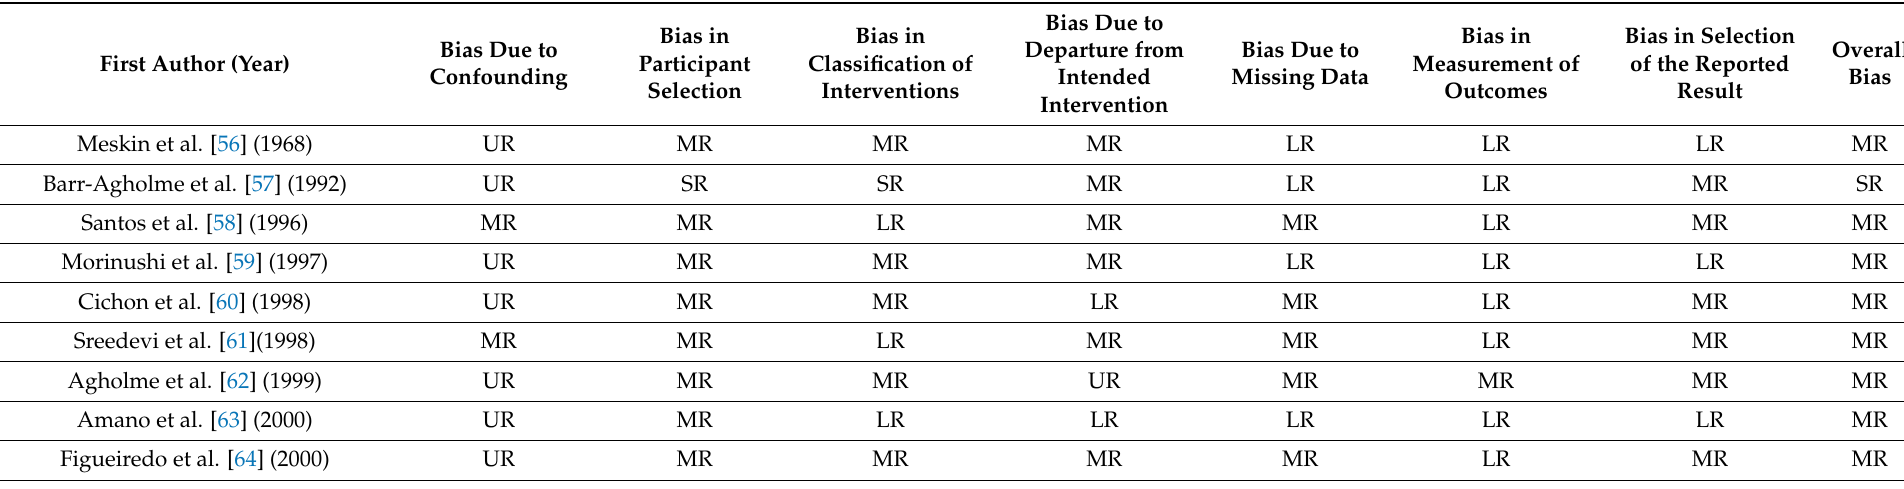
Table 4. Risk of bias assessment for each